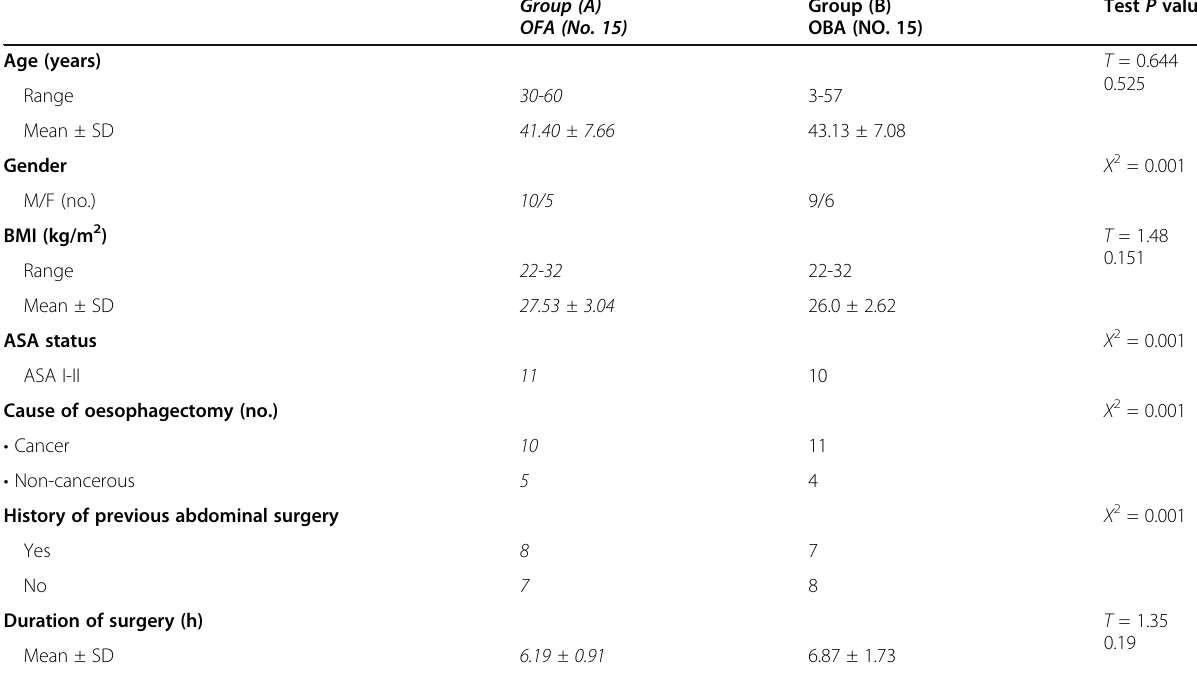
Table 1 Patients ’ characteristics and surgical history of the participants